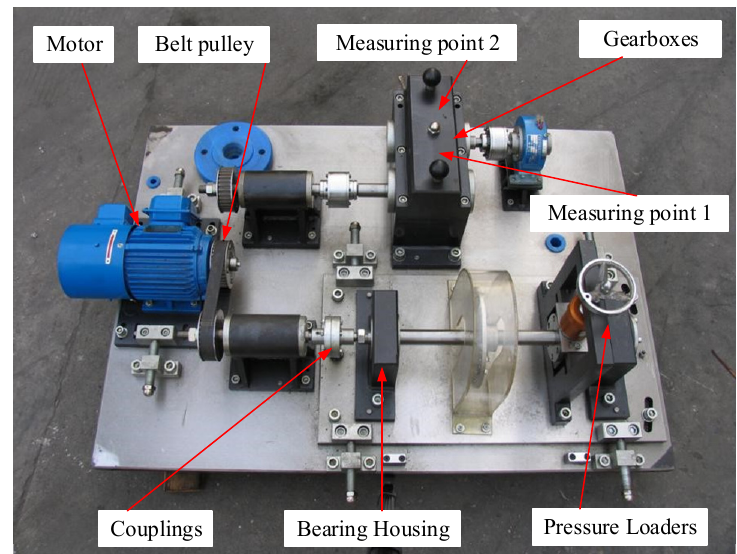
Figure 7. QPZZ-II fault simulation test bench.